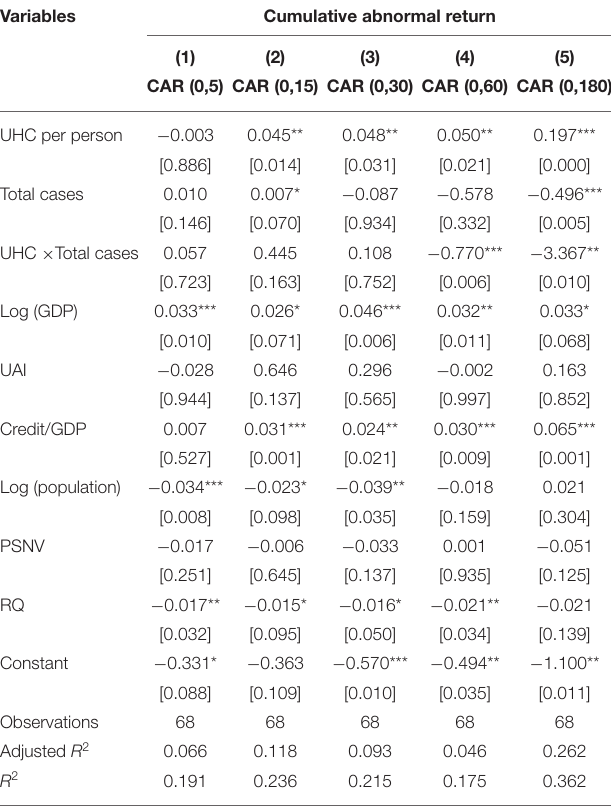
TABLE 6 | Indirect impact of UHC on CARs during the COIVD-19 pandemic. Variables Cumulative abnormal